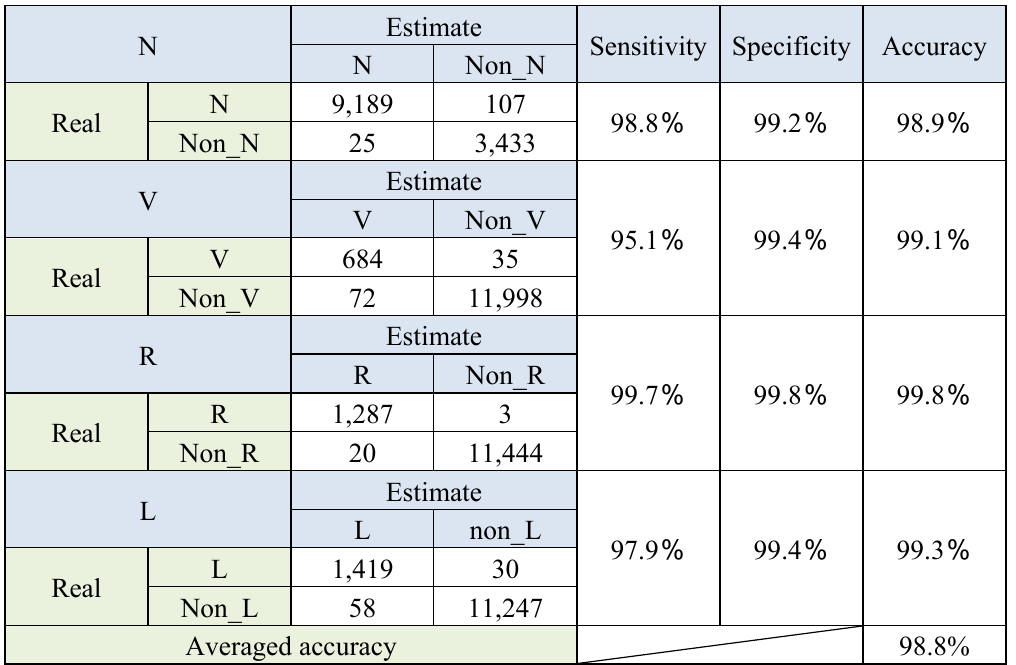
Table 3. Statistical values of the SoNFIN classification results of the test phase in first condition.